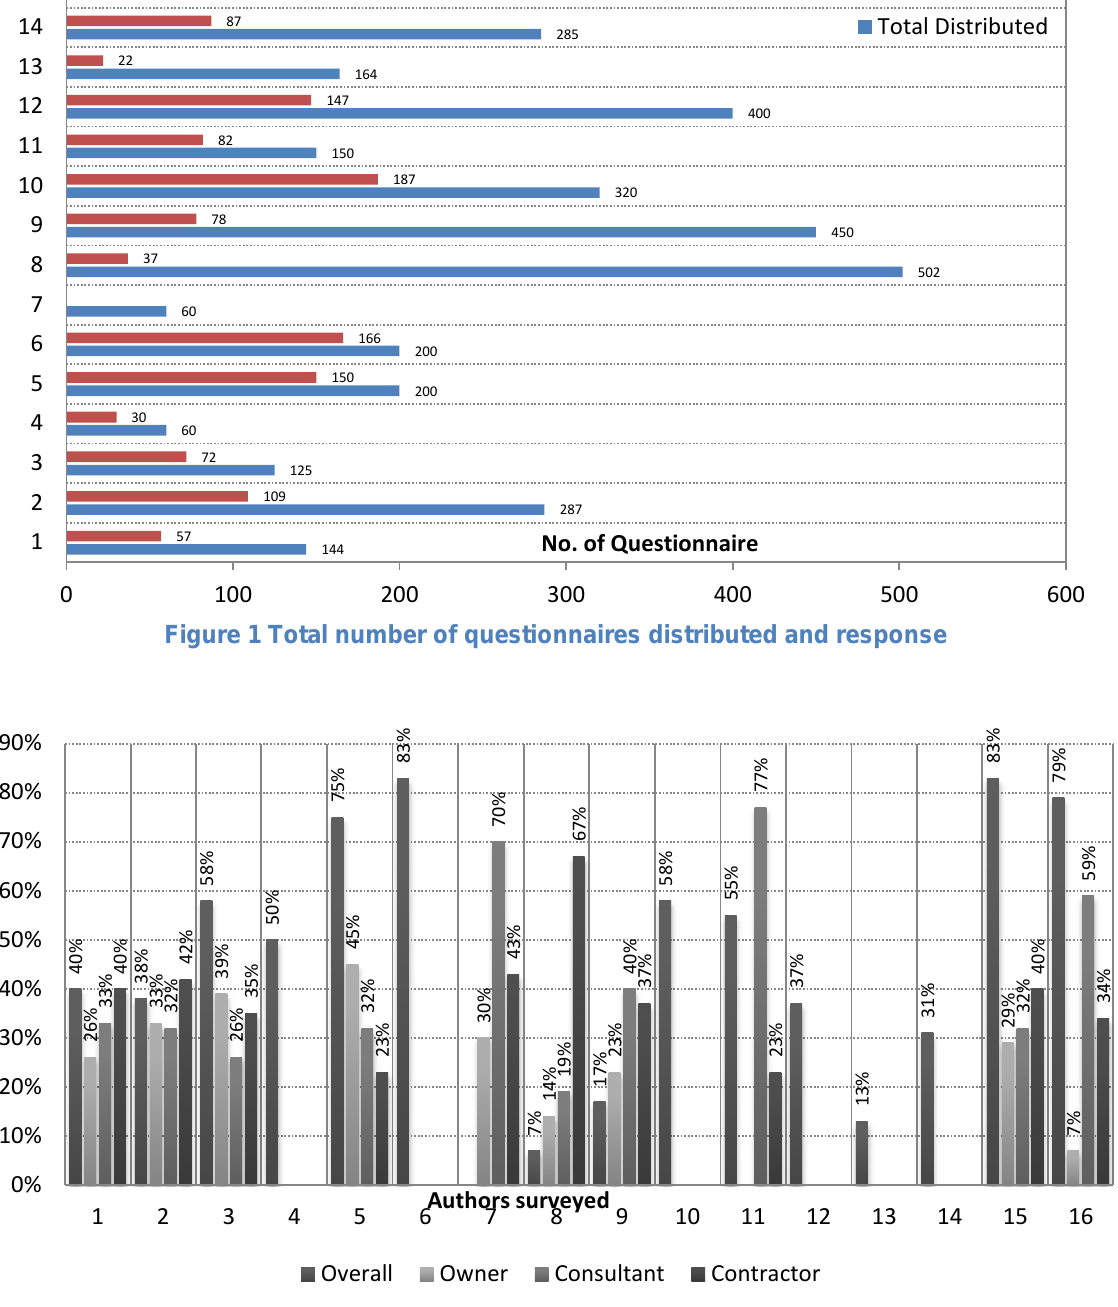
Figure 2 Response rate for different categories for the